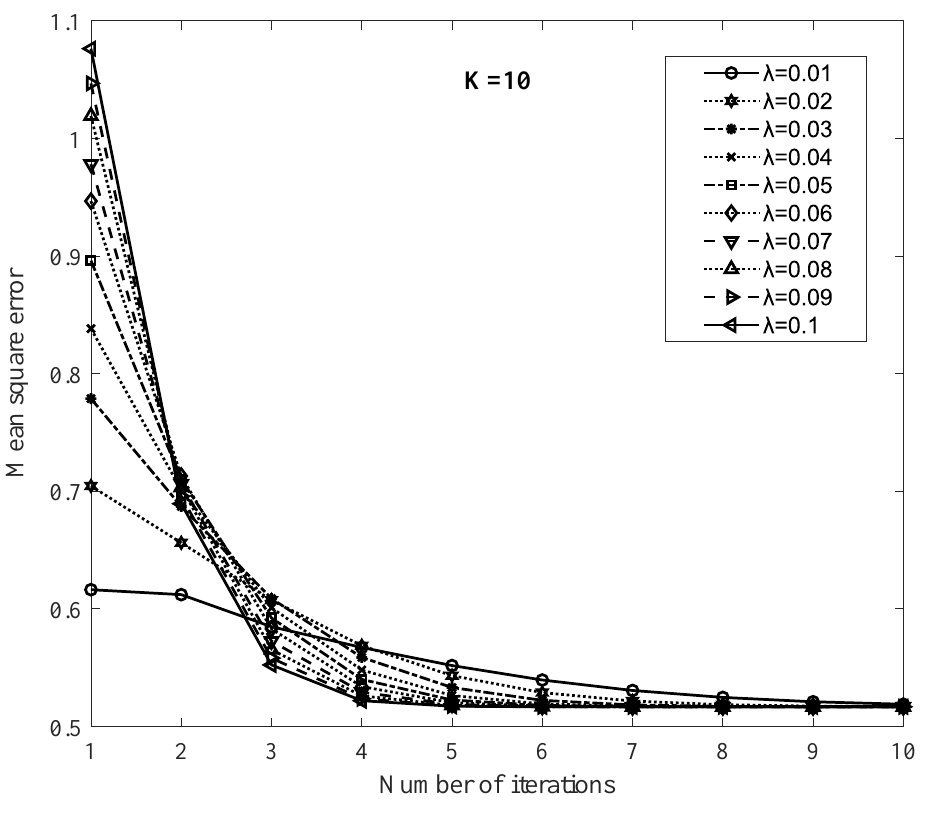
Figure 4. Typical convergence rate of ISGD with varieties of λ .